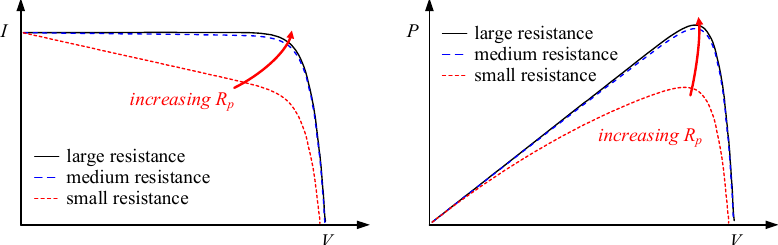
Gradual slope Figure 9. Effects of the slope on the I–V curve and P–V curve. Second, the GBJ2510 is a highly credible and high-temperature-resistant glass passiv- ated bridge rectifier. It uses a GBJ package type of 30 mm × 4.8 mm × 20 mm (W × L × H), which is broader than that of the available thermal pad of TO-247-3 (16.1 mm × 5.2 mm × 21 mm) that is mainly used in discrete-type diodes. Therefore, it is considered advanta- geous for thermal designs. Furthermore, the GBJ2510 has a bridge structure, which is com- posed of a 4-pin (+,~,~,-) terminal, among which the second and third pins are unused, and two diodes are used in series–parallel. In Figure 8, it can be seen that it is superior to the VS-E5TX1512 in terms of loss, because the slope of the I d –V curve is steep. In Figure 8, a difference in power can be observed when the current increased from 1 to 2 A, which allows for an intuitive comparison of the magnitude of the power loss. Last, the C6D20065D (SiC Schottky diode) in CREE is an option which can support up to 650 V and 20 A, with 1.27 V of forward voltage drop. It is true that its slope is most suitable for this design; however, the unit price (online price: USD 8) was not favorable for the multi-diode composition adopted in this research. The package type was a com- mercially used TO-247-3, but its availability was limited, because only CREE supplies this diode. In contrast, the GBJ2510 can handle up to 1000 V and 25 A, with relatively high slope and a price advantage (online price: USD 2). Additionally, Comchip Technology, Panjit, Micro Commercial Components, and SMC Diode Solutions have products with identical names and specifications to those of the typical diode supplier Diode Incorpo- rated, with facilitates the product supply. Therefore, in the proposed PVE, we selected the GBJ2510, which has sufficient stock and is cost effective for the designed hardware. 3.2. Thermal Design